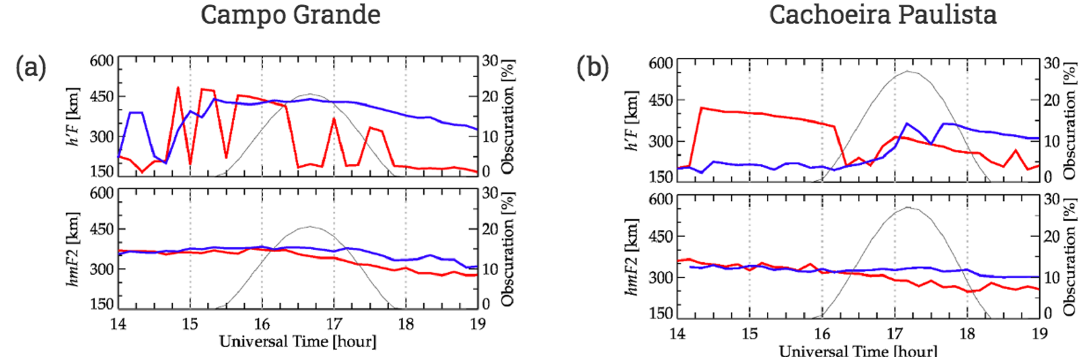
Figure 3. Virtual height h (cid:48) F (top) and F layer peak height hm F2 (bottom) in (a) CG and (b) CXP between 14:00 and 19:00UT. These parameters are presented by the blue line for the quietest day of the month (4 December 2020), and the red line refers to the solar eclipse on 14 December 2020. The grey line represents the solar eclipse obscuration for each region in percent.